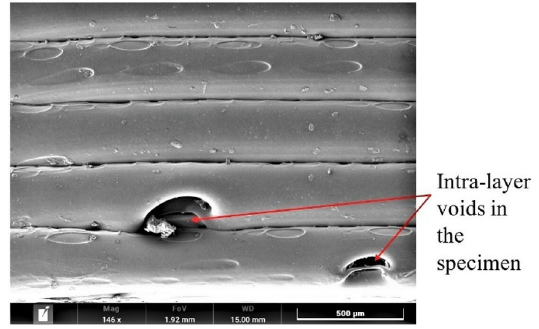
Figure 6 SEM micrograph of specimen obtained from